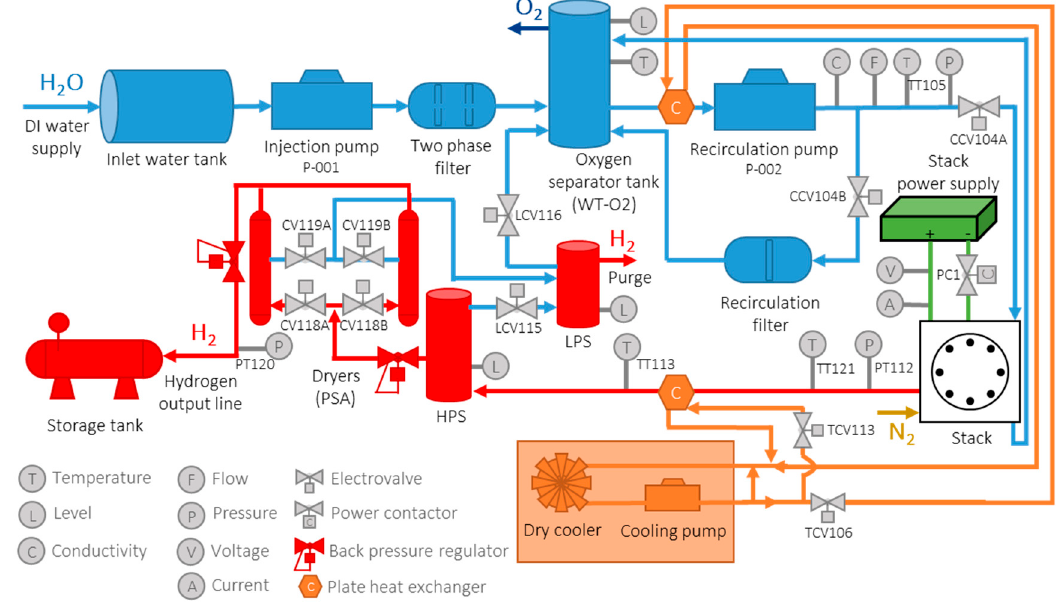
Figure 4. Balance of plant (BOP) of the developed PEM electrolyzer.